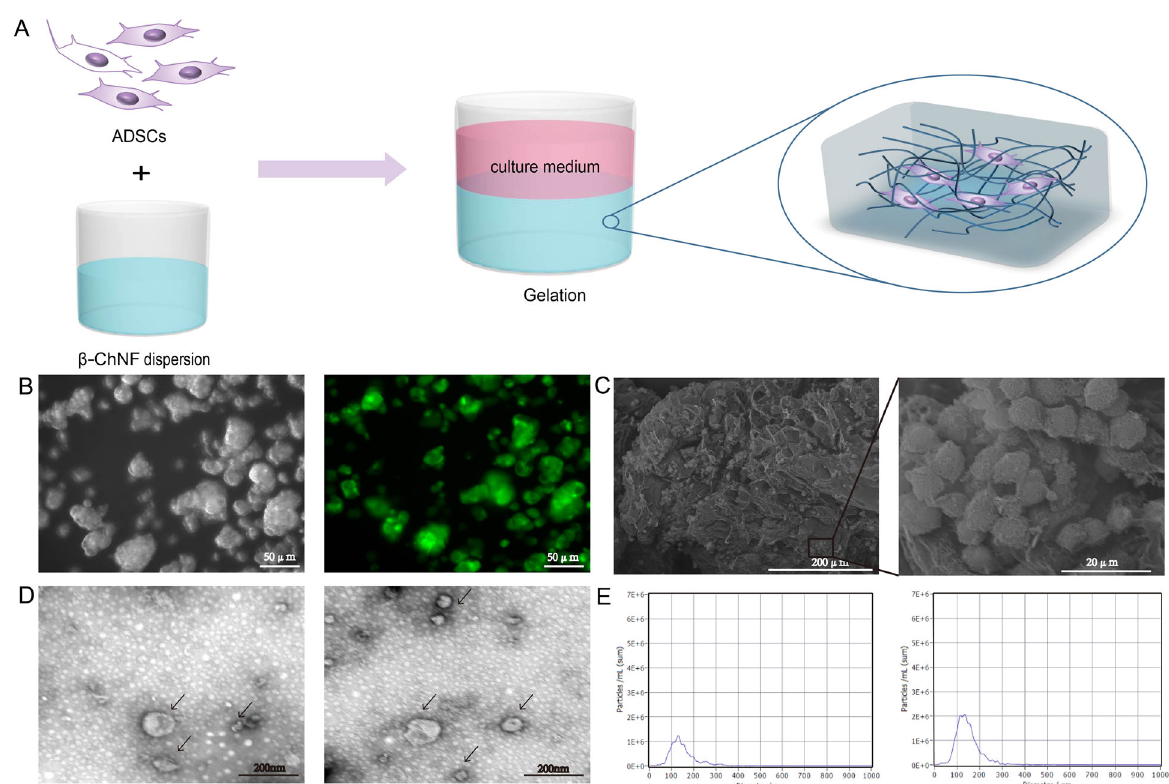
Fig. 2 Growth of ADSCs in β -chitin hydrogel. A The stepwise dia- gram for preparation of ADSCs-loaded β -ChNF hydrogel. B Globular ADSCs grown in the β -chitin hydrogel scaffold, and the micro- examination proved the growth of GFP-labeled ADSCs. C SEM images of the ADSCs-loaded β -ChNF hydrogel. D Transmission